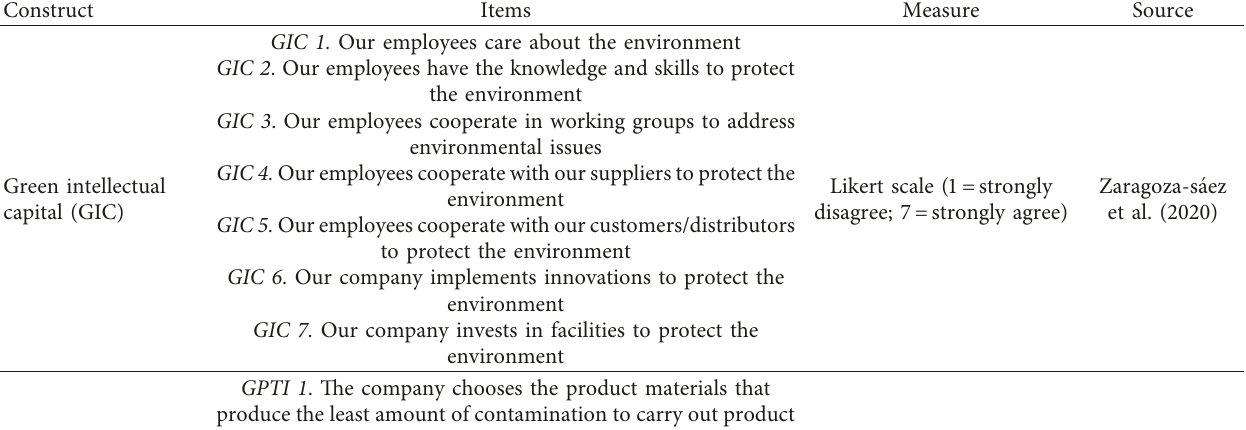
Table 1: Measurement of the variables